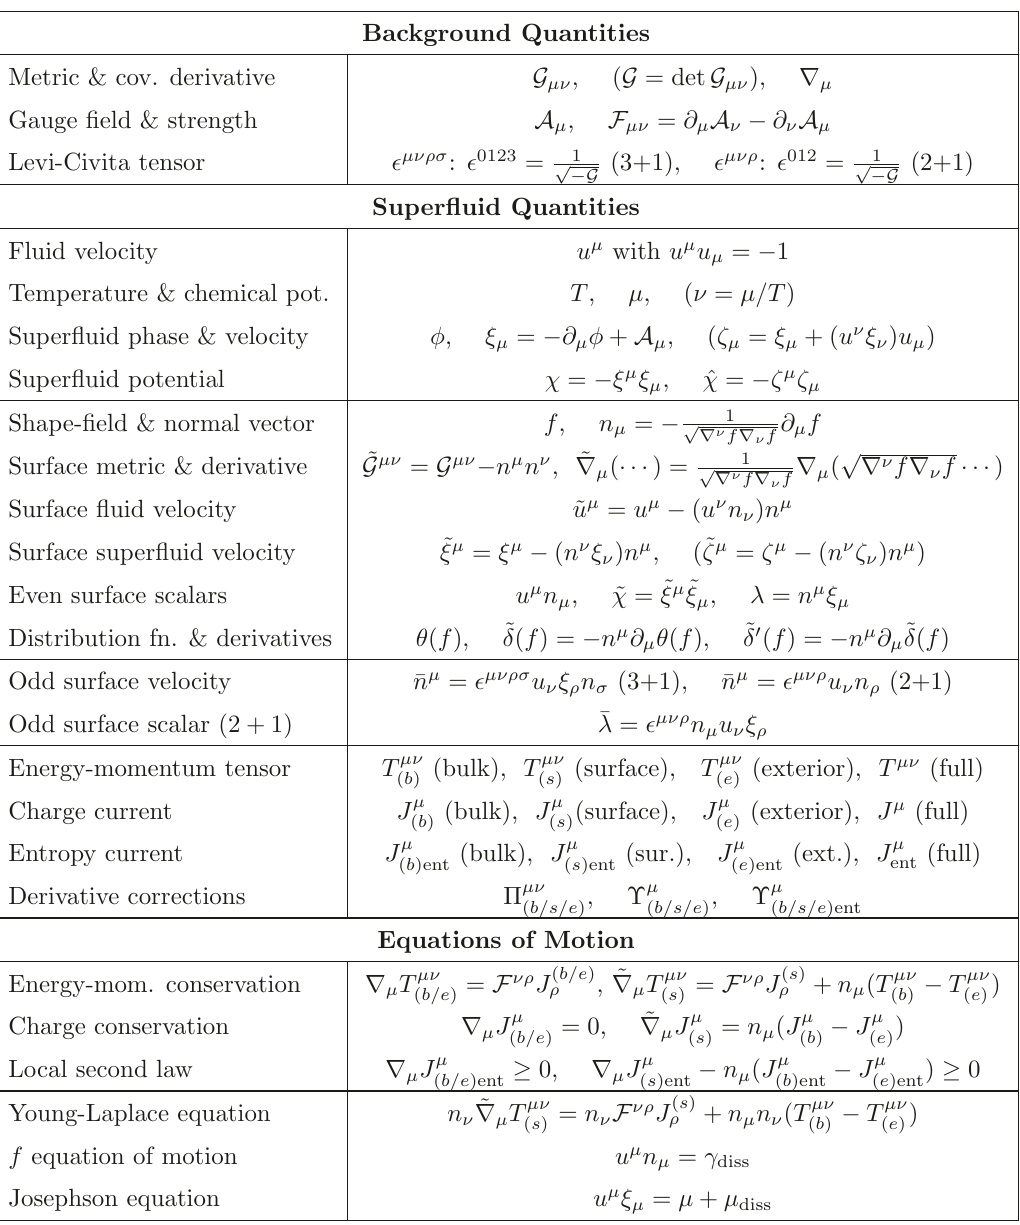
Table 3 . Quick reference guide for relativistic superfluid bubbles (Part